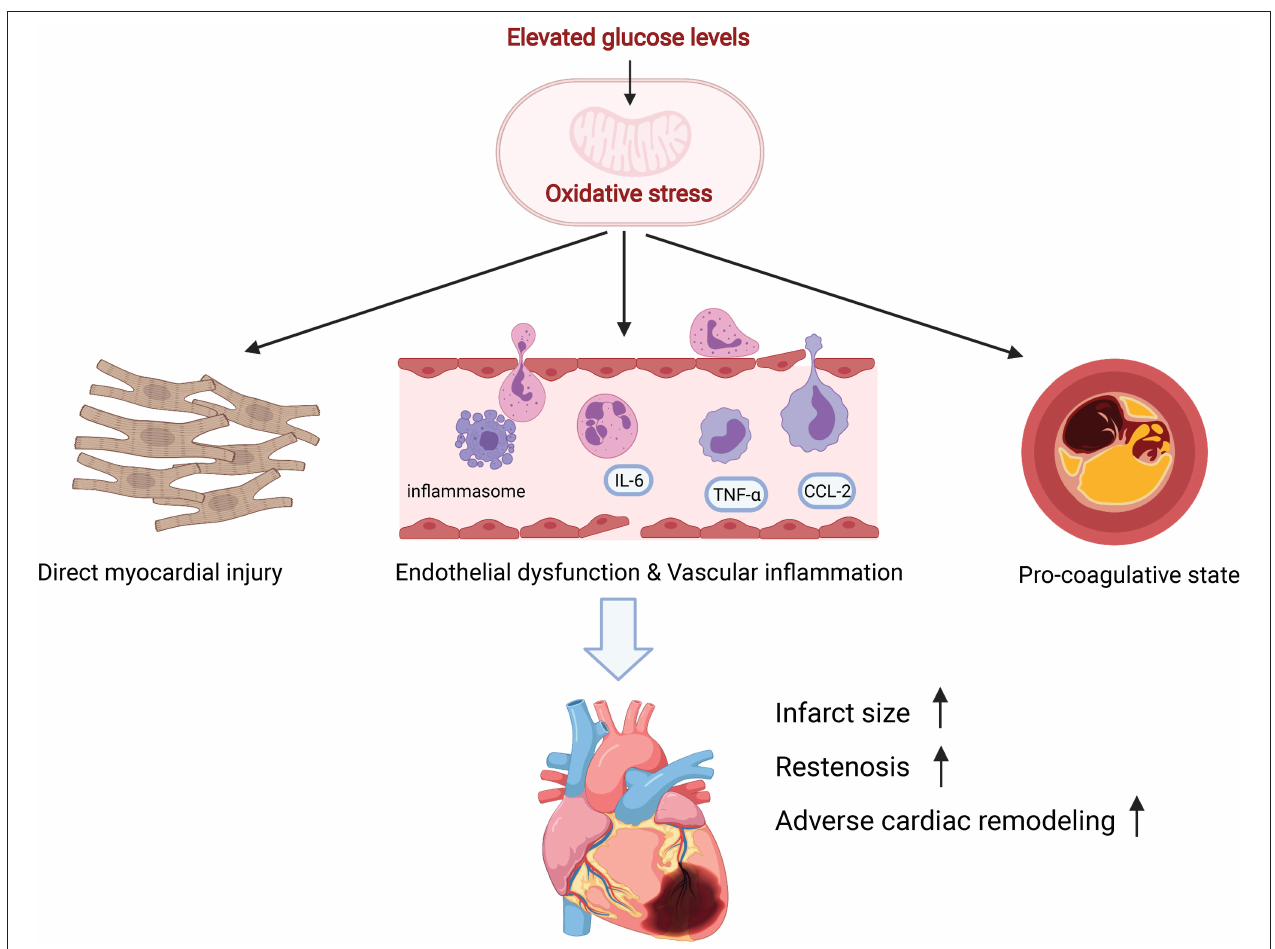
FIGURE 1 | Postulated mechanisms underlying detrimental effects of